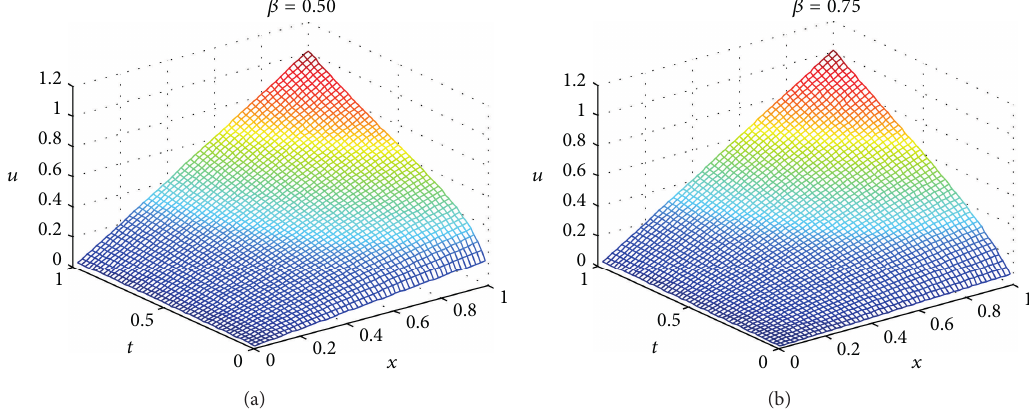
Figure 3: Numerical results of Example 25 for different value of 𝛽 .